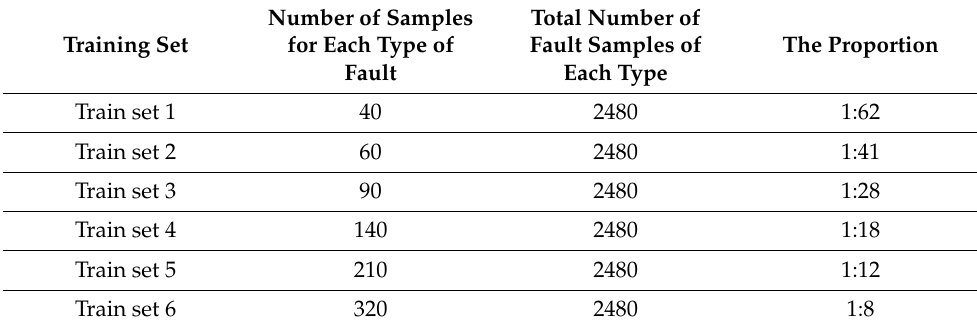
Table 2. Sample size for each target domain training set in the